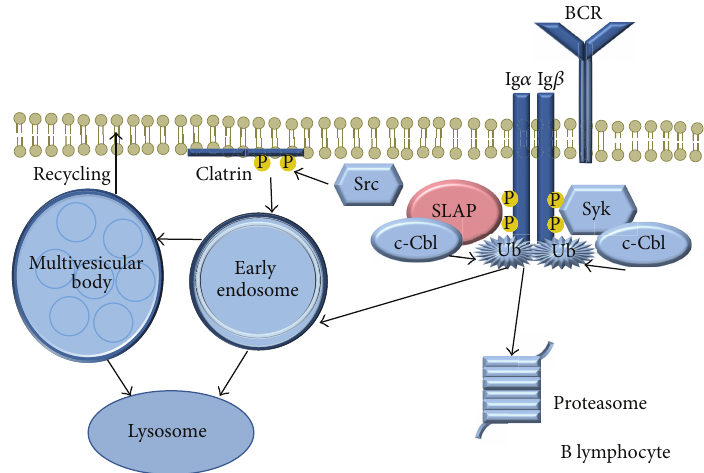
Figure 4: The role of SLAP in B